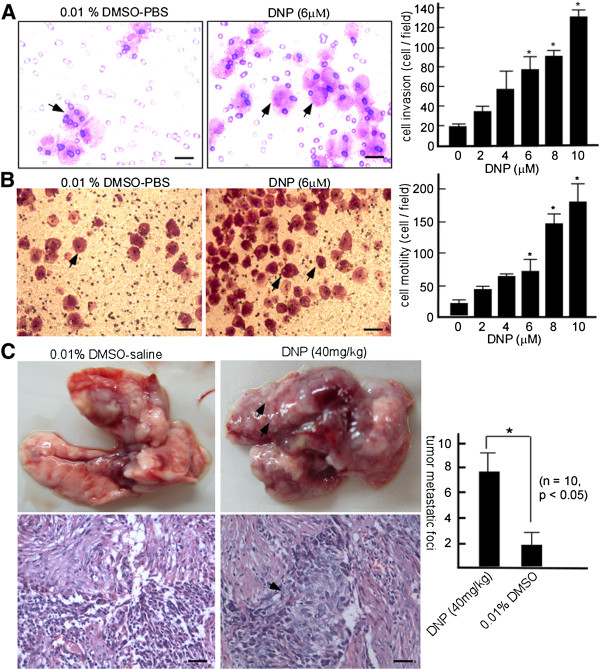
DNP-mediated 6-10B cell invasion and motility in vitro or metastasis in vivo. A, stable isotope-labeled 6-10B cells were treated with the indicated DNP concentration for 24 h. The treated cells were subjected to analyses for motility and invasion as described in the Materials and Methods. A, invasion of 6-10B cells at various concentrations. Arrow, invaded cell. B, motility of 6-10B cells at various concentrations; Arrow, motile cell. The data were statistically analyzed by one-way analysis of variance with post hoc Dunnett’s test (*, p < 0.05). Scale bar, 5 μM. C, twenty nude mice were injected with 6-10B cells in Matrigel through the tail vein (1 × 104 cells/mouse), and then randomly divided into two groups with 10 mice per group. The DNP group was abdominally injected with DNP using a stumped needle at a dosage of 40 mg/kg (bodyweight), twice a week for 60 days. The control was injected with 0.1% DMSO. After 60 days, tumor metastatic foci of 6-10B cells were observed. Scale bar, 10 μM. Arrow, tumor metastatic foci.